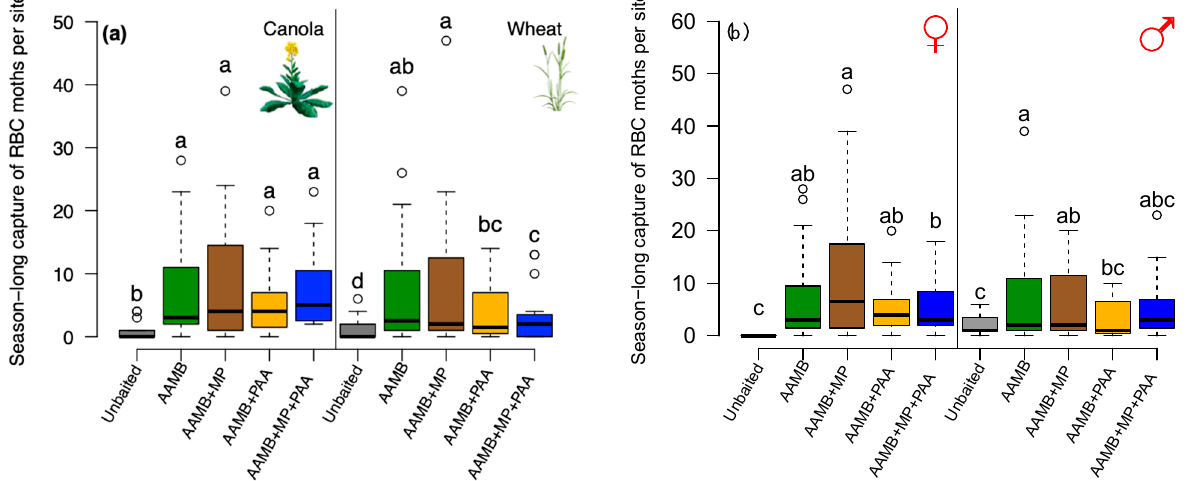
Figure 4. Experiment 4—box-and-whisker plots of the season-long capture of redbacked cutworm (RBC) moths in traps baited with AAMB lures with and without additional chemical compounds. ( a ) By crops: in canola fields ( left panel) and wheat field ( right panel); ( b ) by sex: female ( left panel) and male ( right panel). Open circles represent points more than 1.5 times the interquartile range. The tested chemicals were alcohols from fermented by-products, 2-methyl-1-propanol (MP), and a floral volatile, phenylacetaldehyde (PAA). Treatments included AAMB alone, AAMB+MP, AAMB+PAA, AAMB+MP+PAA and an unbaited trap that served as the control. Means comparisons were per- formed for difference in moth trap catch in traps baited with the different food bait lures. Boxplots marked with different letters within each crop type are statistically different (Tukey method, α =